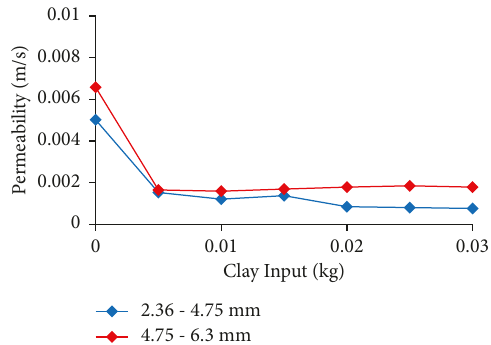
Figure 9: Comparison of permeability due to clay clogging.